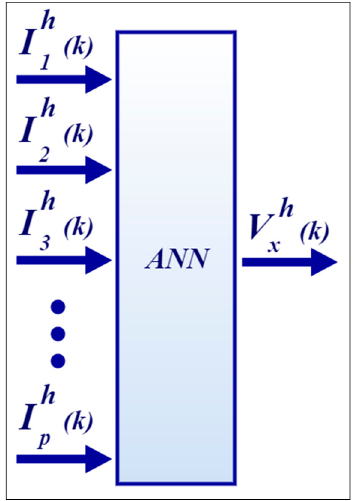
Figure 2. General representation of the ANN input-output relationship.